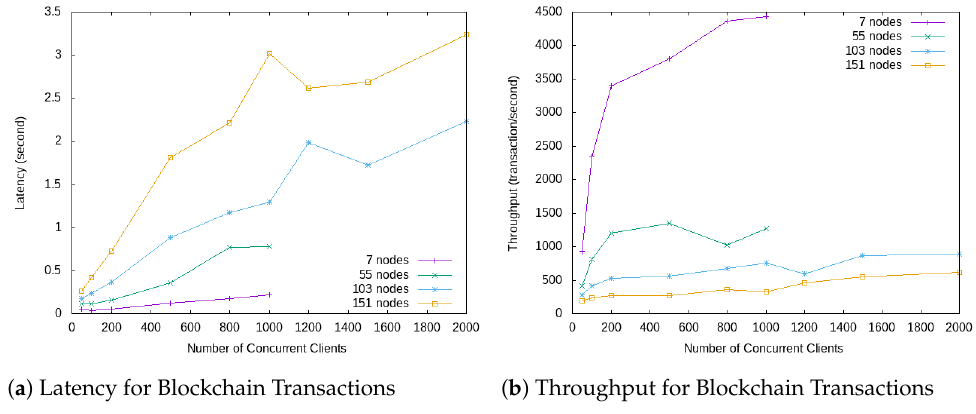
Figure 15. Latency and throughput performance for Blockchain